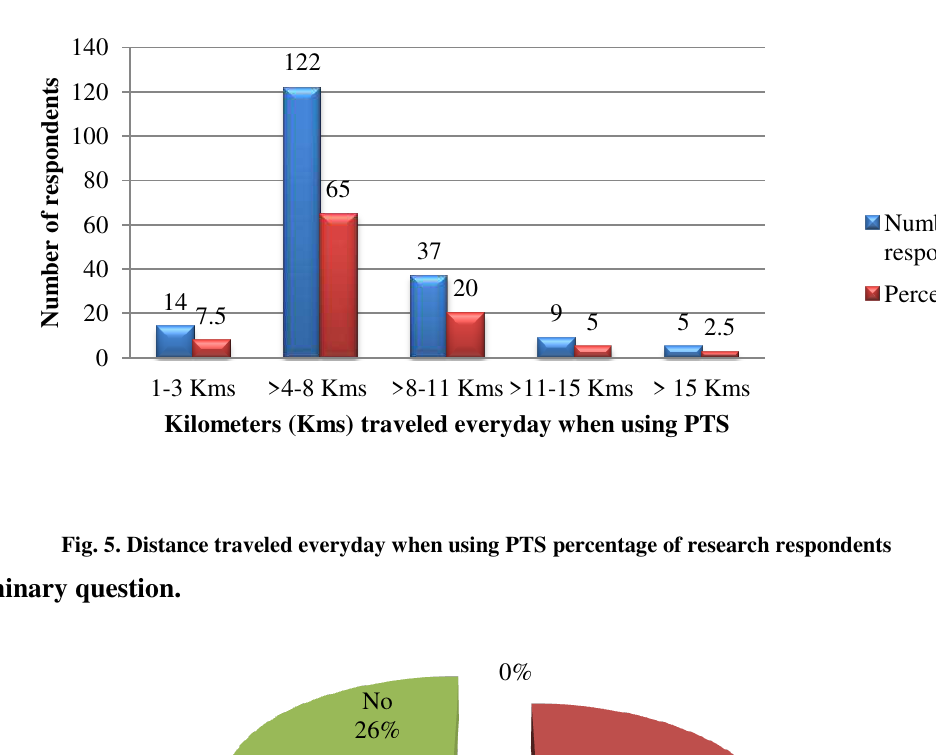
Fig. 4. Public transport service experience percentage of research respondents